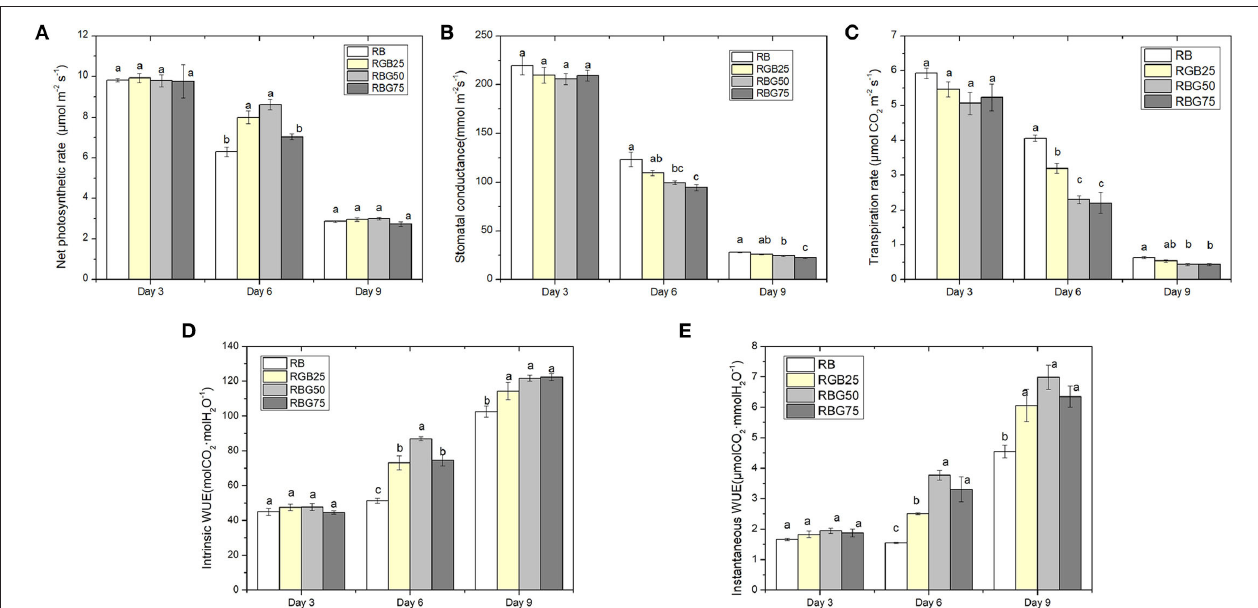
FIGURE 4 | Effect of different spectral conditions on gas exchange parameters of fully expanded cucumber leaves under short-term drought stress. (A) Net photosynthetic rate (Pn), (B) Stomata conductance (gs), (C) Transpiration rate (Tr), (D) Lintrinsic water use efficiency (WUE) and (E) Instantaneous water use efficiency (iWUE) of cucumber leaves at 3 d, 6 d and 9 d. RB, RBG25, RBG50 and RBG75 are the different spectral conditions, respectively. The PPFD for all the treatments was 250 µ mol m − 2 s − 1 . The data presented were the means ± SE ( n = 3). Different lowercase letters on the bar chart indicated significant differences among treatments according to Tukey’s test ( p < 0.05).